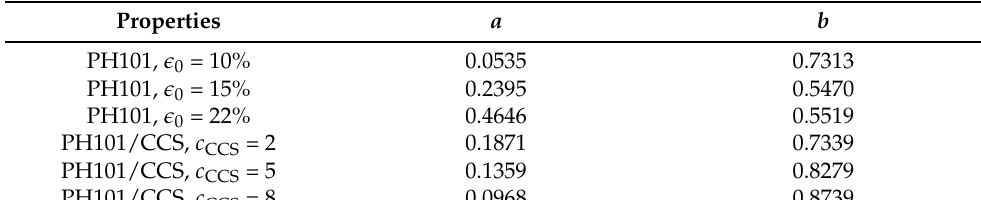
Table 6. Parameters of the power law ( y = a · t b ) describing the experimental liquid penetration depth data.